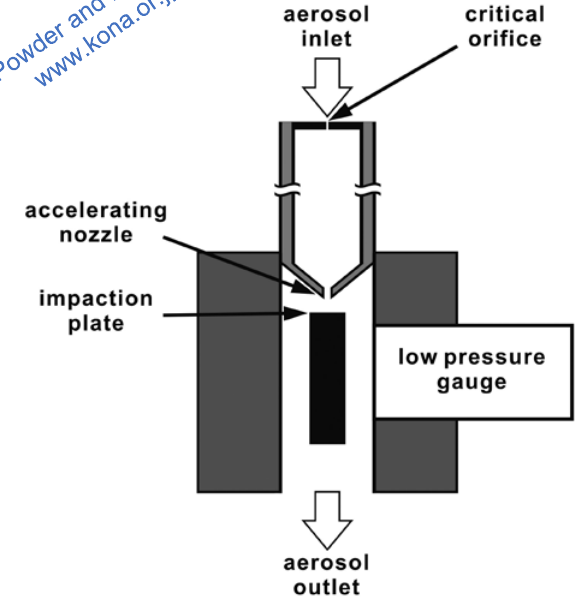
Fig. 3 Schematic of the low-pressure